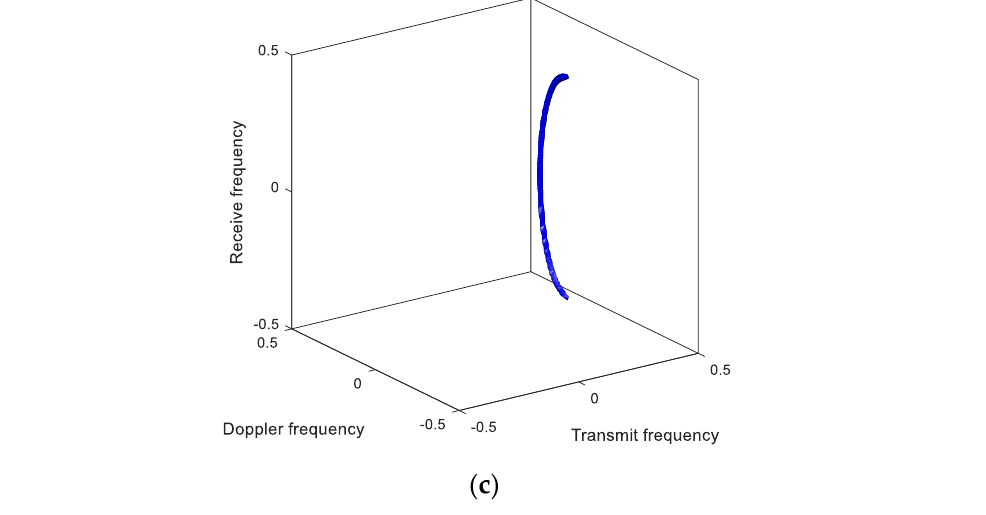
Figure 10. dB ambiguous clutter power spectrum. ( a ) MIMO; ( b ) FDA; ( c ) MLC FDA.